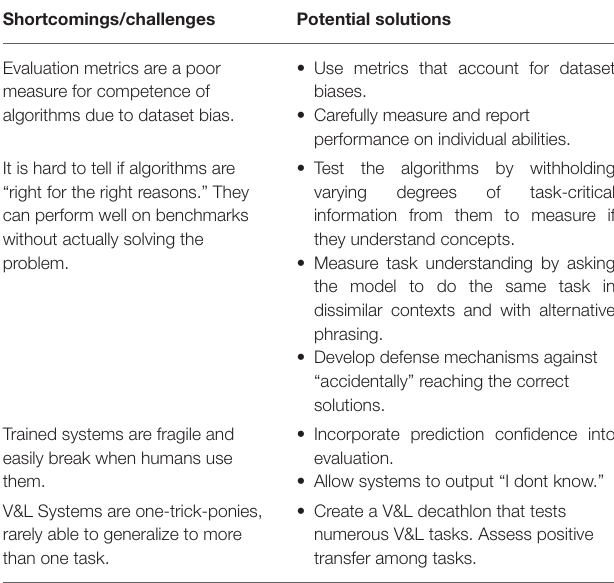
TABLE 1 | A summary of challenges and potential solutions for V&L